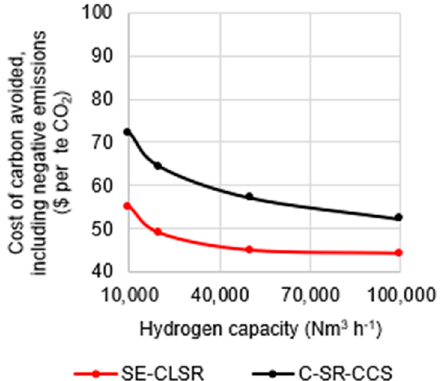
Figure 8. Cost of carbon avoided in C-SR-CCS and SE-CLSR, compared to bio-oil C-SR base